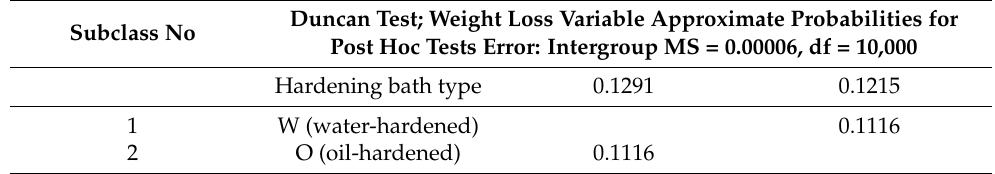
Table 10. The results of variance analysis of Vanadis 60 SuperClean steel wear value in the medium soil. Duncan Test; Weight Loss Variable Approximate Probabilities Subclass No